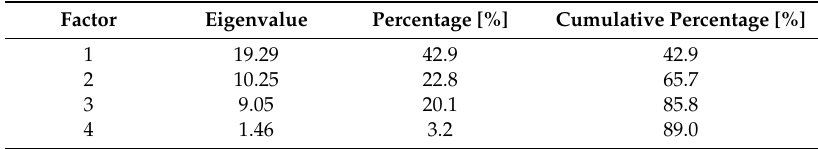
Table 1. Results of the factorial analysis with the principal components extraction method.